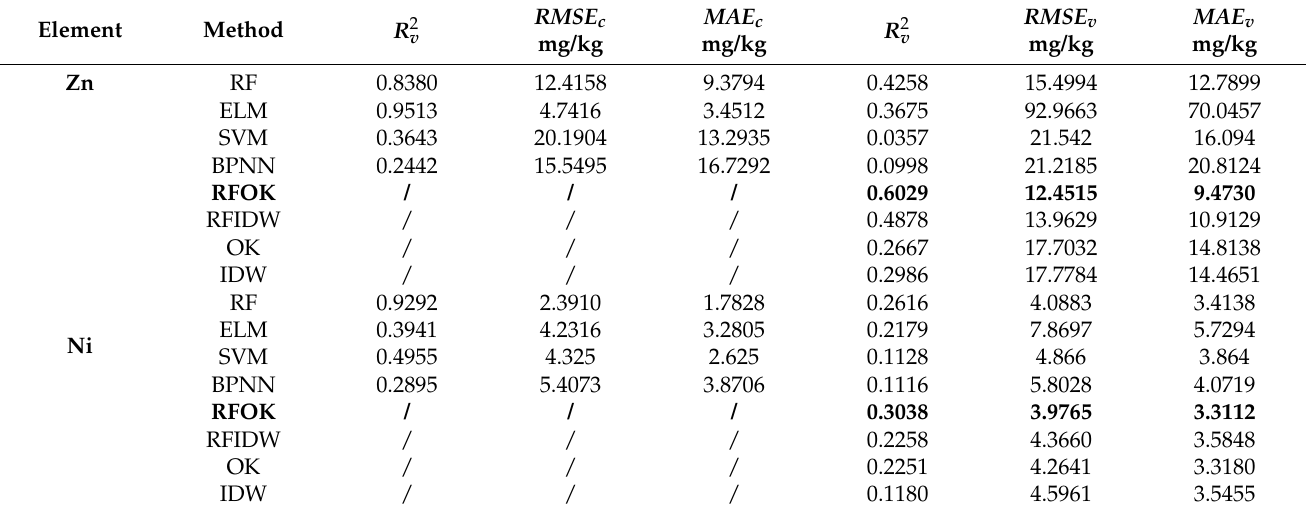
Table 2. Heavy metal concentrations map accuracy